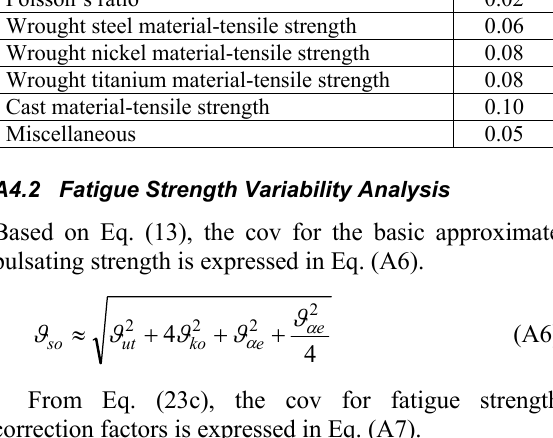
Table A1: Covs for Some Strength Parameters and Materials Strength Parameters Poisson’s